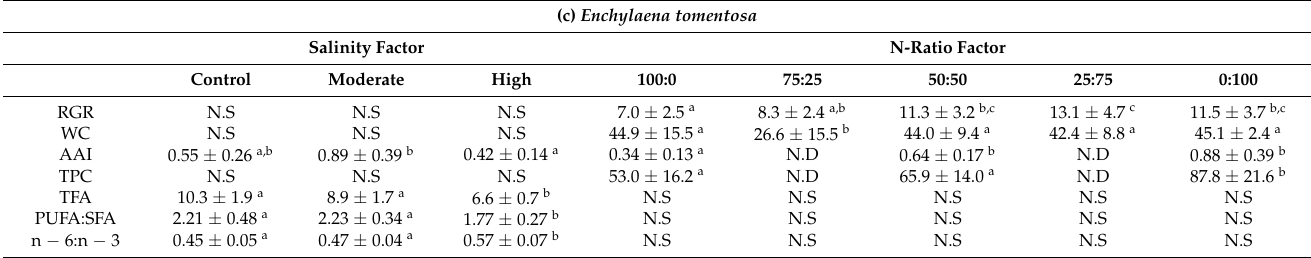
(c) Enchylaena tomentosa